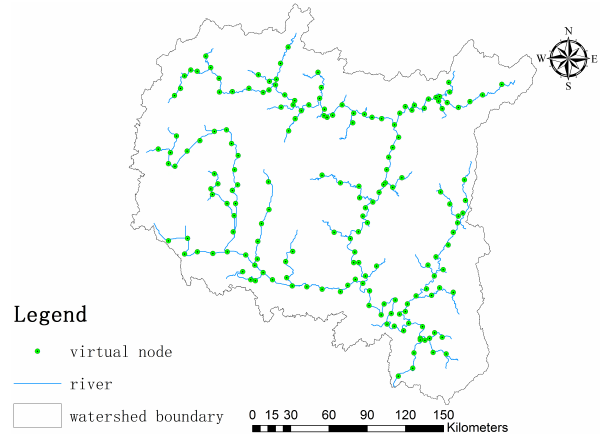
Figure 5. Liuxihe model structure of the LRB (200m × 200m res- olution, Chen et al., 2017).